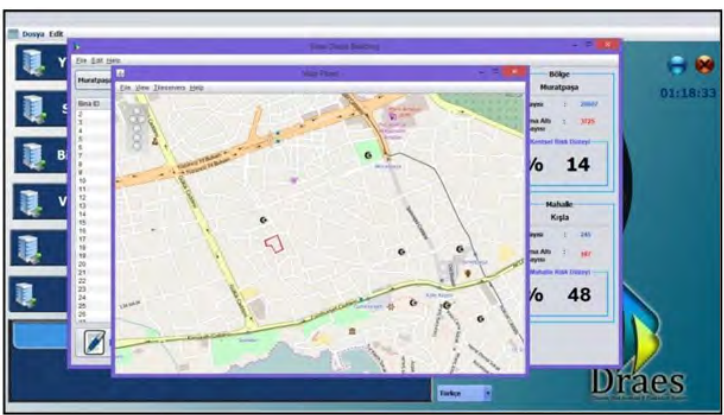
Figure 10. Territory Map Service